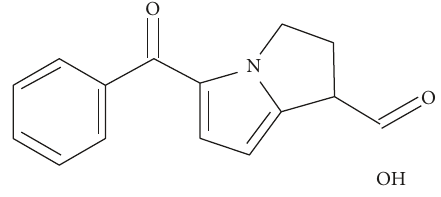
Figure 1: Chemical structure of